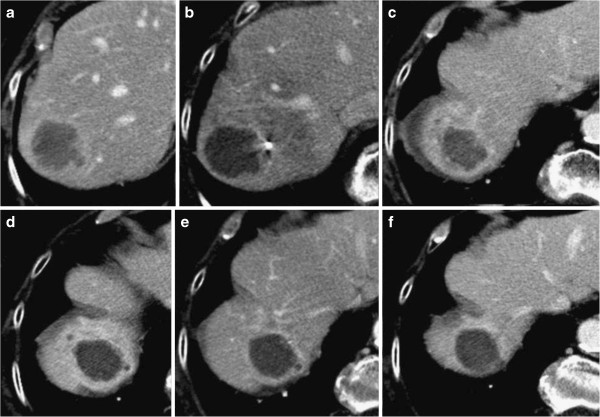
Complete response after SBRT for a liver metastasis over successive follow-ups. Before treatment (a); 2 months later (b), we observe changes of the initial phase: target-shaped lesion surrounded by a peripheral enhancement and located in a hypodense area with well delineated demarcation between irradiated and normal liver; CT slices performed at portal phase at 5 months (c); 9 months (d); 12 months (e); and 24 months later (f) show that the center is better circumscribed by a thin rim enhancement, the hypodense area progressively shrank and became hyperdense.